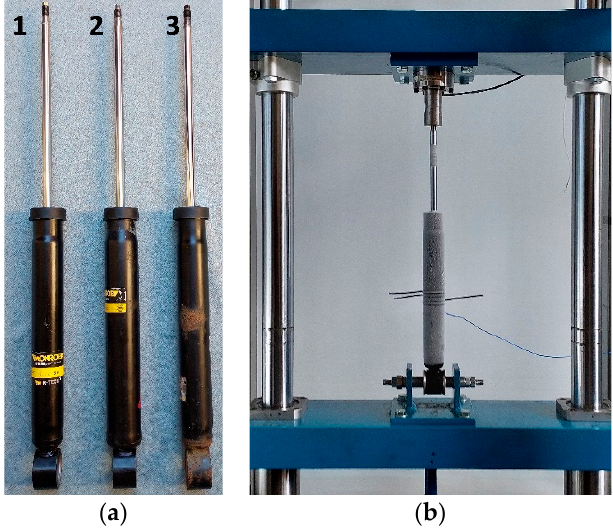
Figure 1. Testing stand: ( a ) view of the tested shock absorbers; ( b ) shock absorber mounted on the stand.